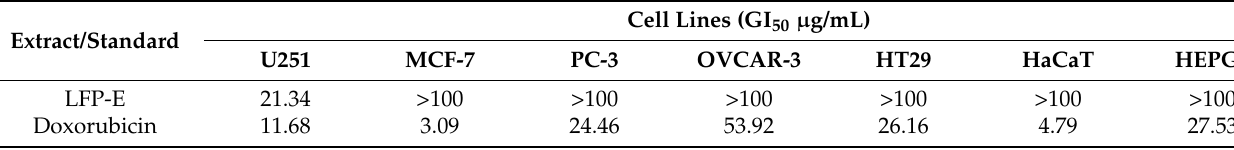
Table 3. Antiproliferative activity of A. crassiflora hydroethanolic extract against human tumor cell lines.